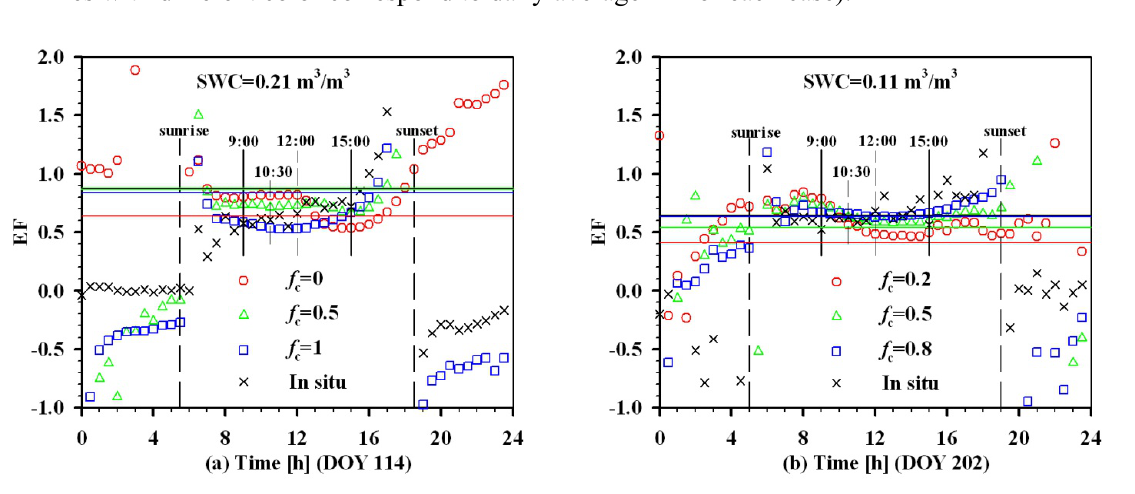
Figure 5. Relationships between daily average EF and EF at different times in one day for ( a ) ALEX-simulated data driven by the atmospheric forcing at the Yucheng station in 2010, and ( b ) in situ measurements at the Yucheng station during the wheat growth period in